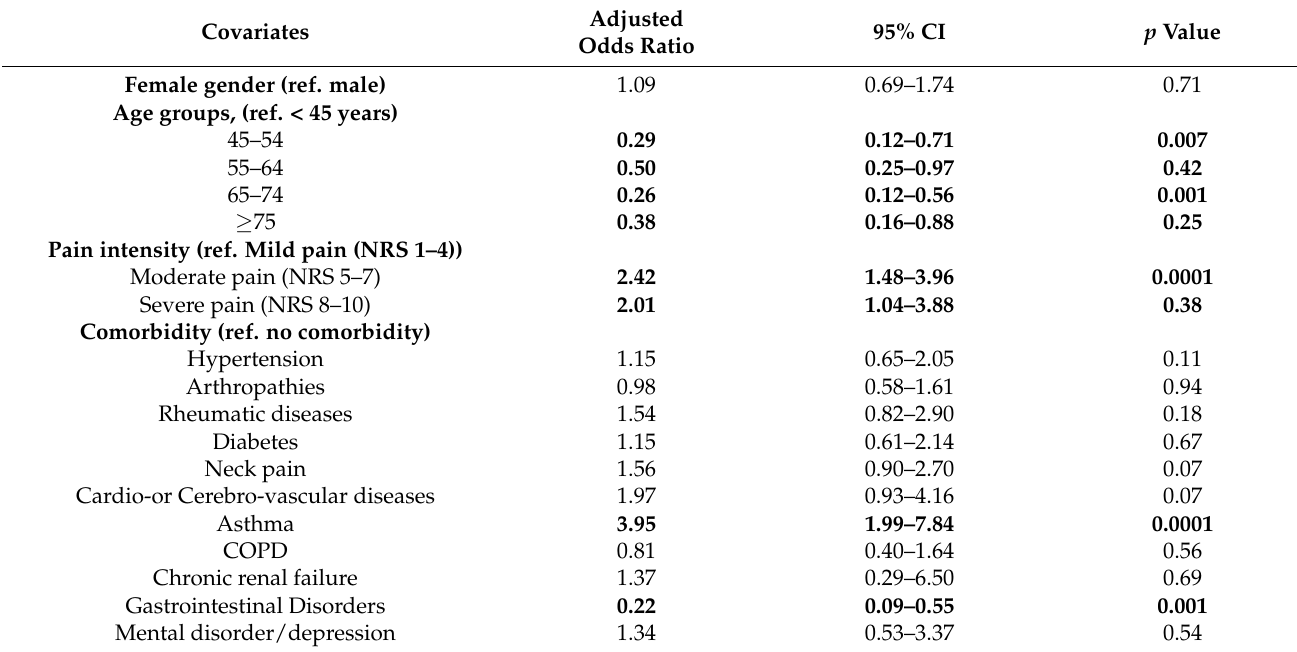
Table 2. Clinical and demographic factors associated with an opioid prescription (ref. NSAID). Covariates